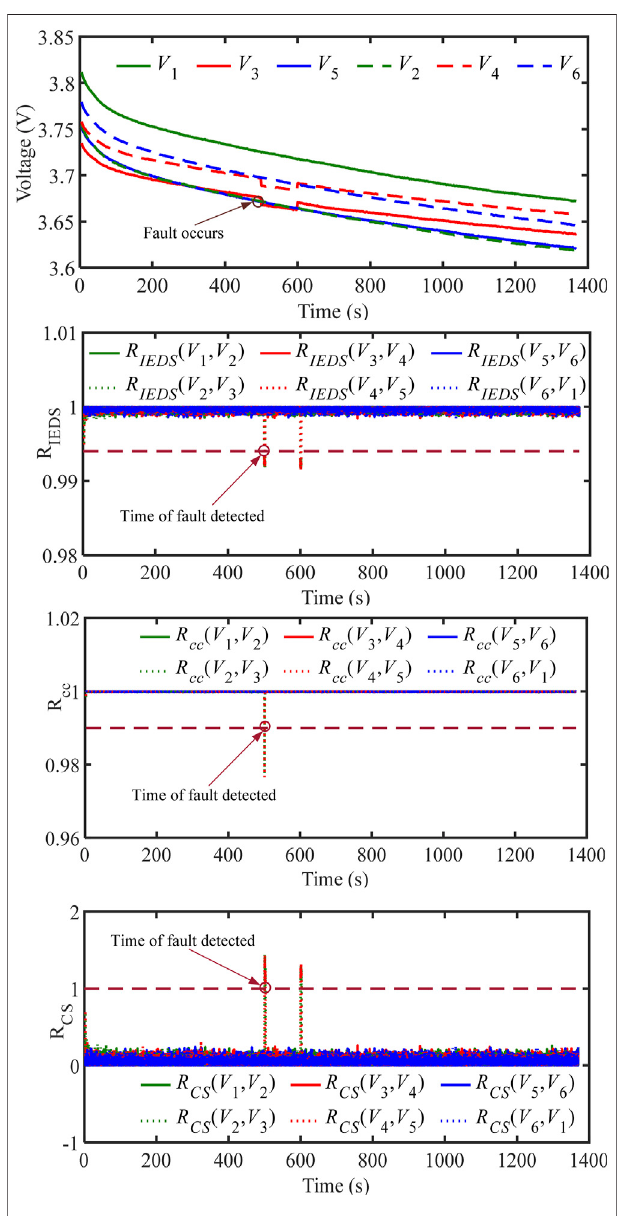
FIGURE 11 | ISC fault evaluation results. (a) Voltage curve. Diagnosis by (b) R IEDS , (c) R cc , (d) R CS